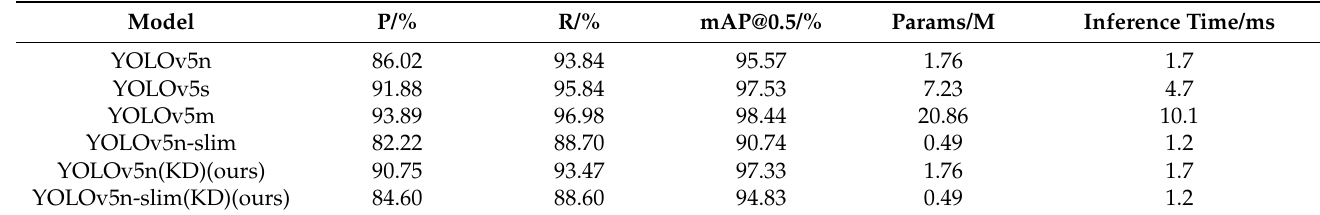
Table 5. Comparison of detection performance of each model.